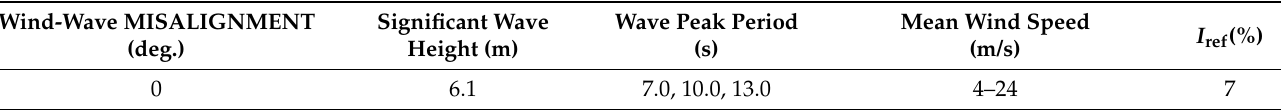
Table 6. The environmental conditions for the extreme sea states. Wind-Wave MISALIGNMENT